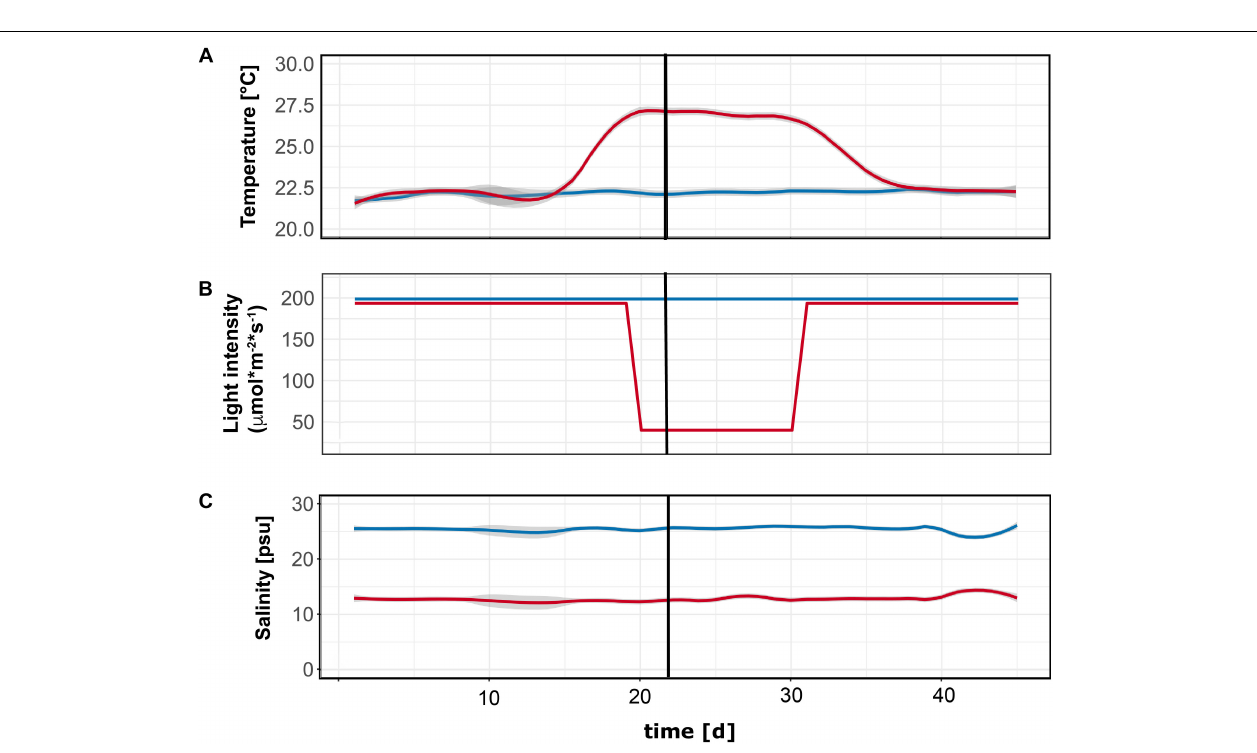
FIGURE 2 | Environmental parameters during the inoculation experiment. Panels depict (from top to bottom) temperature ( ◦ C, A ), light ( µ mol · m − 2 · s − 1 , B ), and salinity (psu, practical salinity units, C ) values over time. Black vertical line indicates the day when eelgrass plants were inoculated with Labyrinthula zosterae (or sham-inoculation as